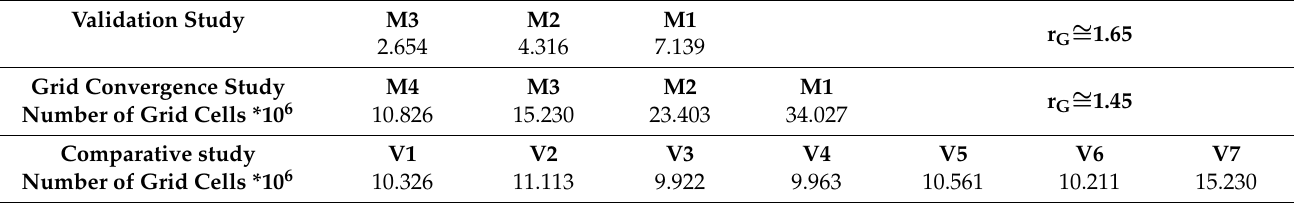
Figure 4. The finest discretization grid for the complex geometry V7, showing, respectively, a 3D domain grid, a 3D hull grid and bottom and side views. Table 3. Number of grid cells for simulation